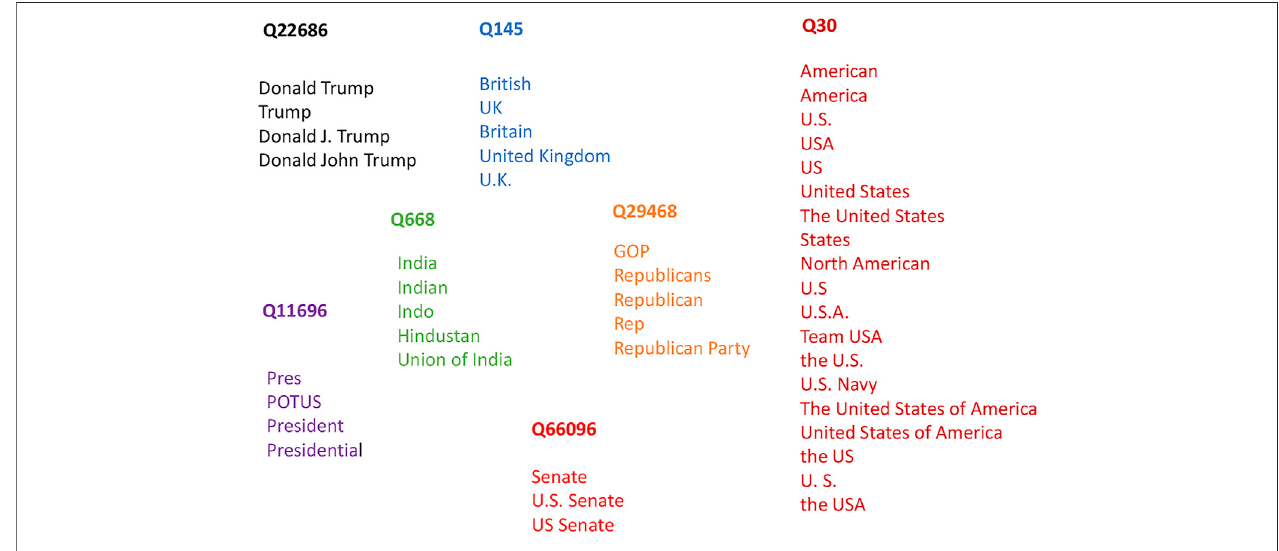
FIGURE 1 | Examples of linked entities.